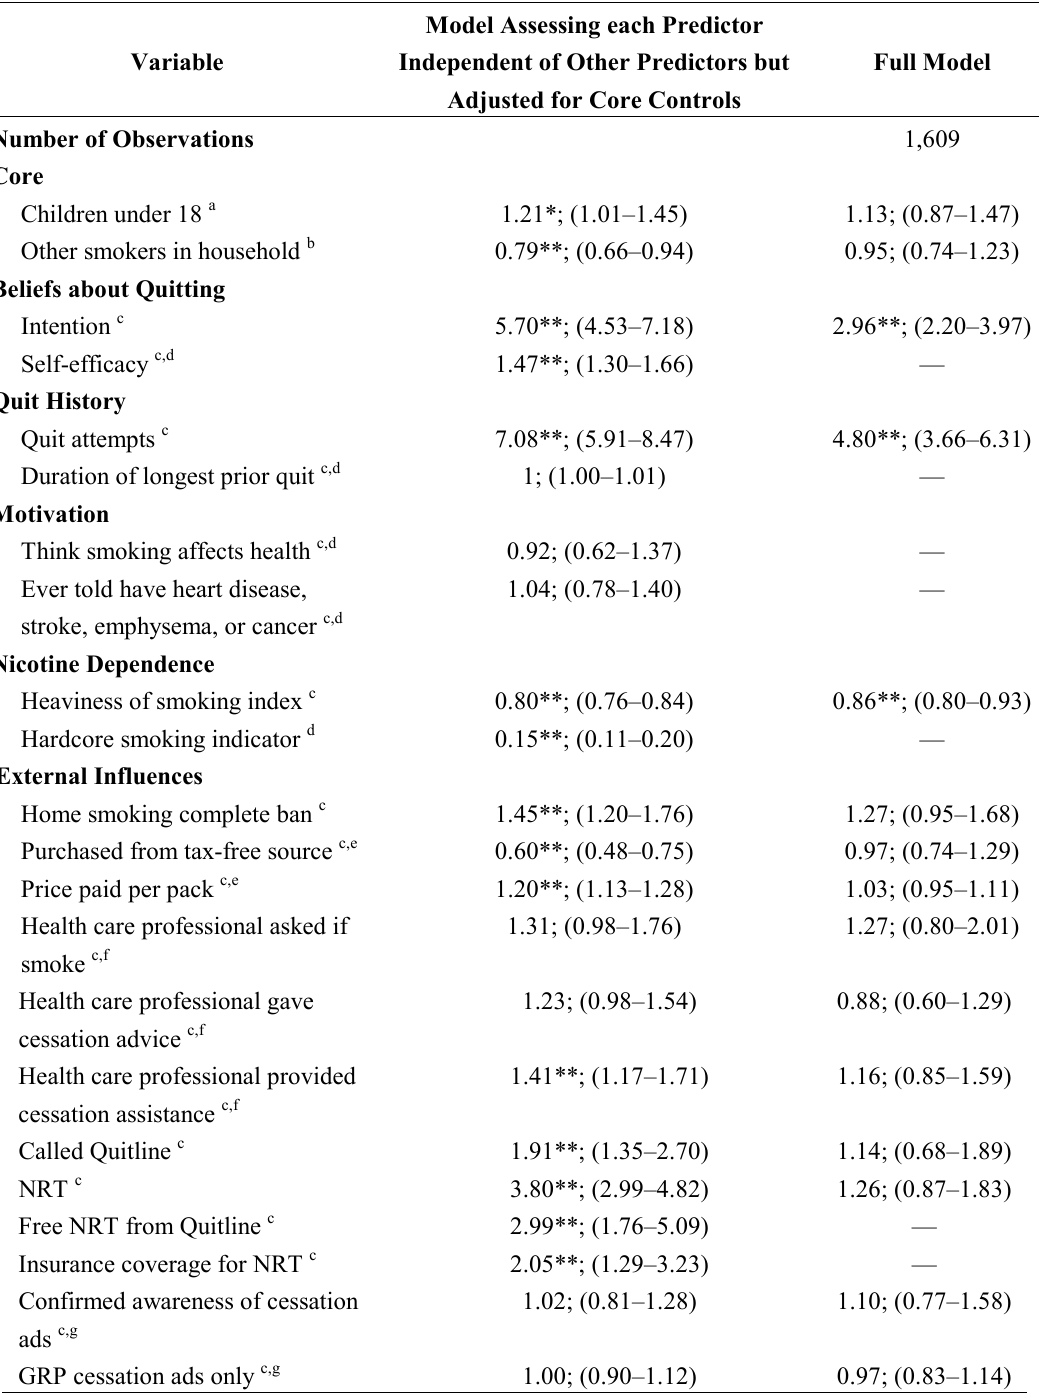
Table 2. Predictors of quit